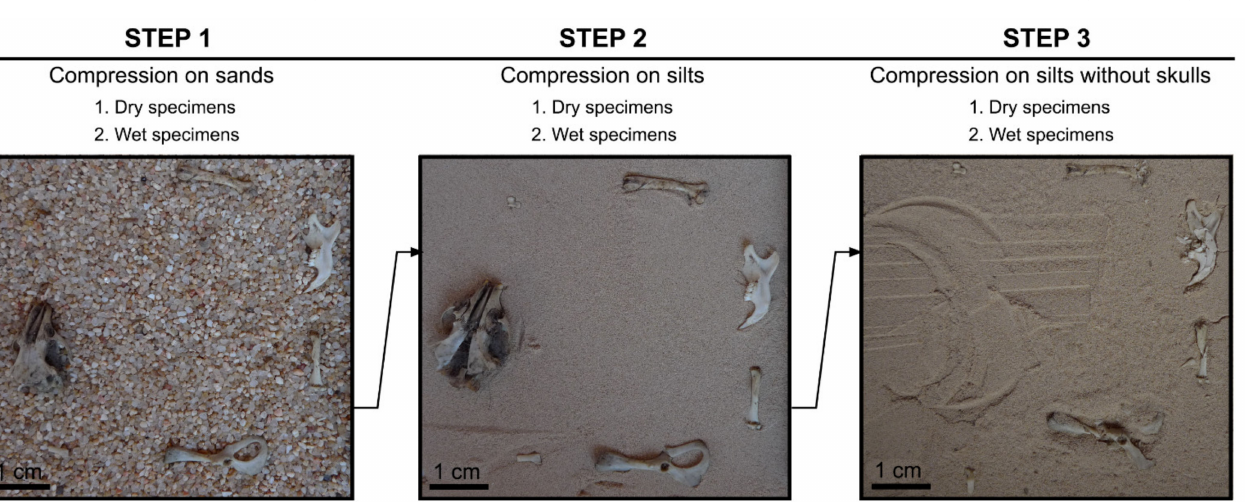
Figure 2. Each set of specimens as shown in this figure was compressed in (1) coarse sand substrate + all the skeletal elements, (2) silty substrate + all the skeletal elements, (3) silty substrate + postcranial elements only, repeated three times and carried out for dry and wet specimens with the skeletal elements in a different position each time.